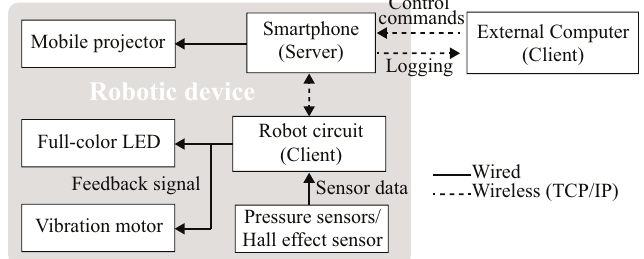
Figure 2. Device components: composed by a smartphone that communicates with the robot’s circuit and an external